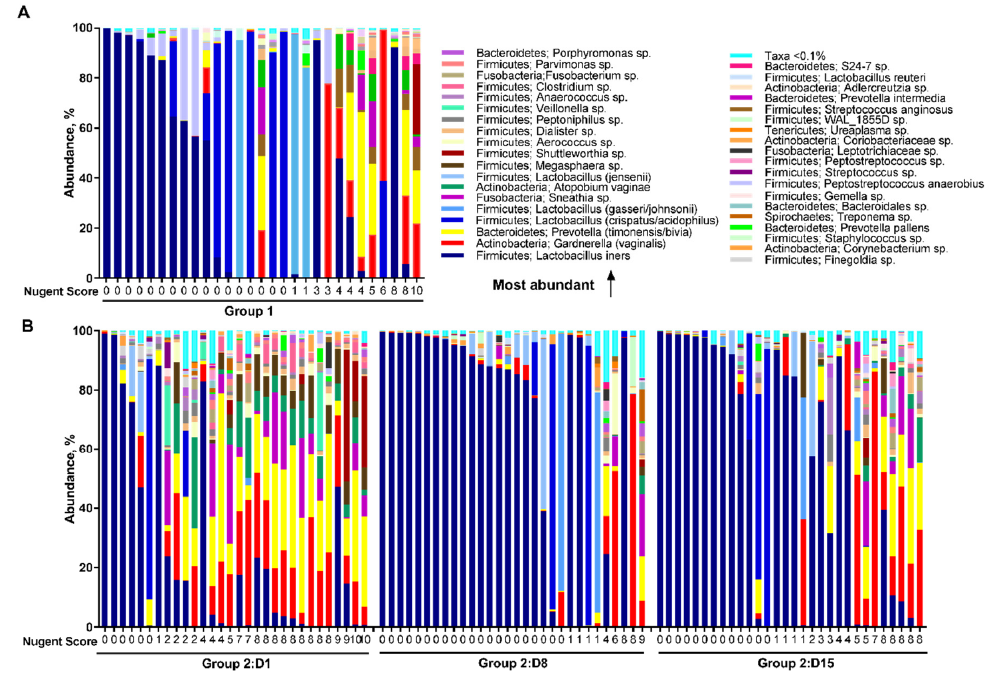
Figure 4 . The relative abundance of vaginal microbiota species for participants in Group 1 ( A ) and Group 2 ( B ), in order of study day and increasing Nugent score. Group 2 ( B ), in order of study day and increasing Nugent